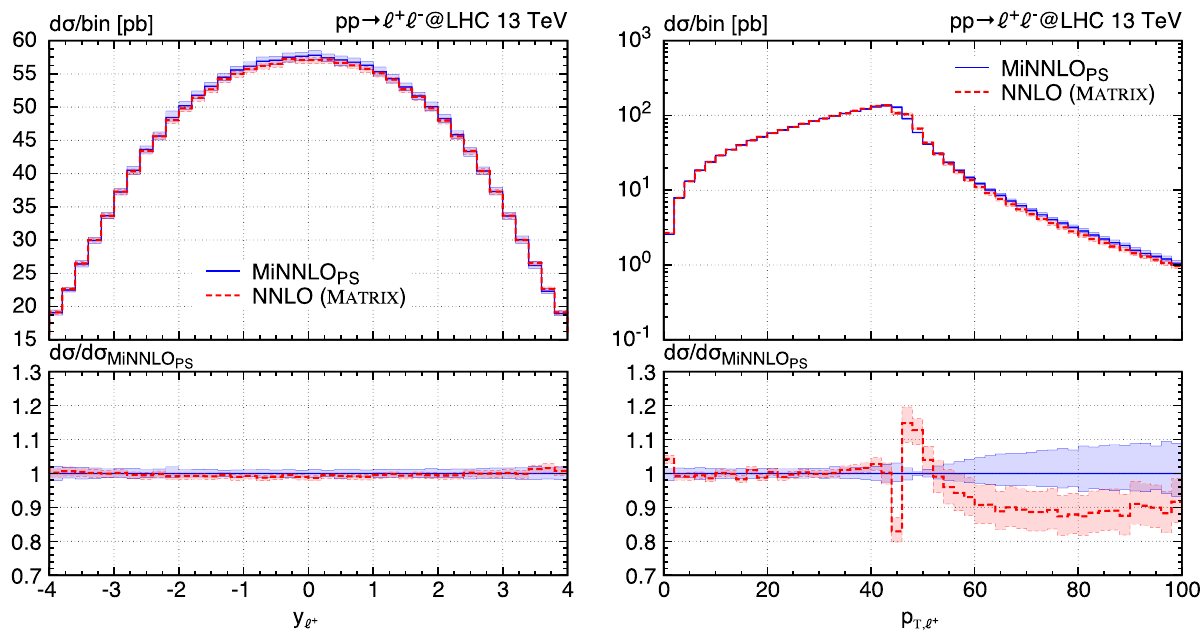
Fig. 4 Rapidity distribution (left) and transverse momentum (right) of the positively charged lepton in neutral-current Drell Yan production. The lower panel shows the ratio to the MiNNLO PS prediction